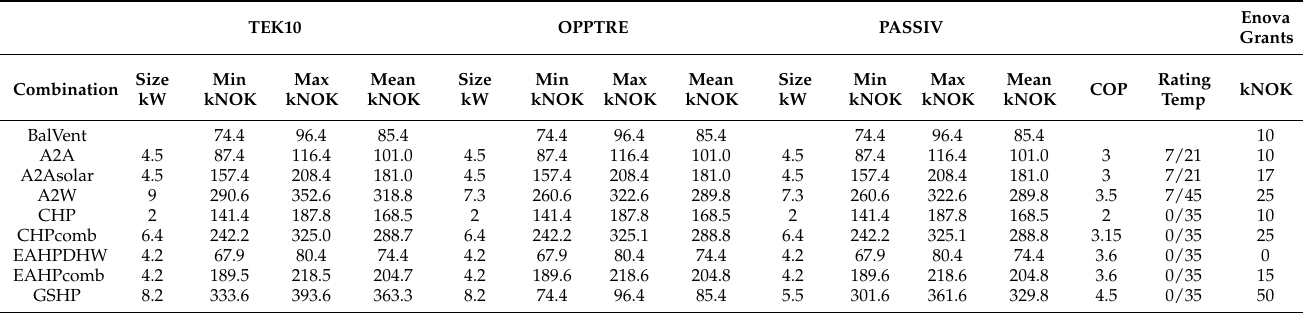
Table 4. Nominal heat pump capacity, COP, and investment costs of the different HVAC combinations for the Kristiansand